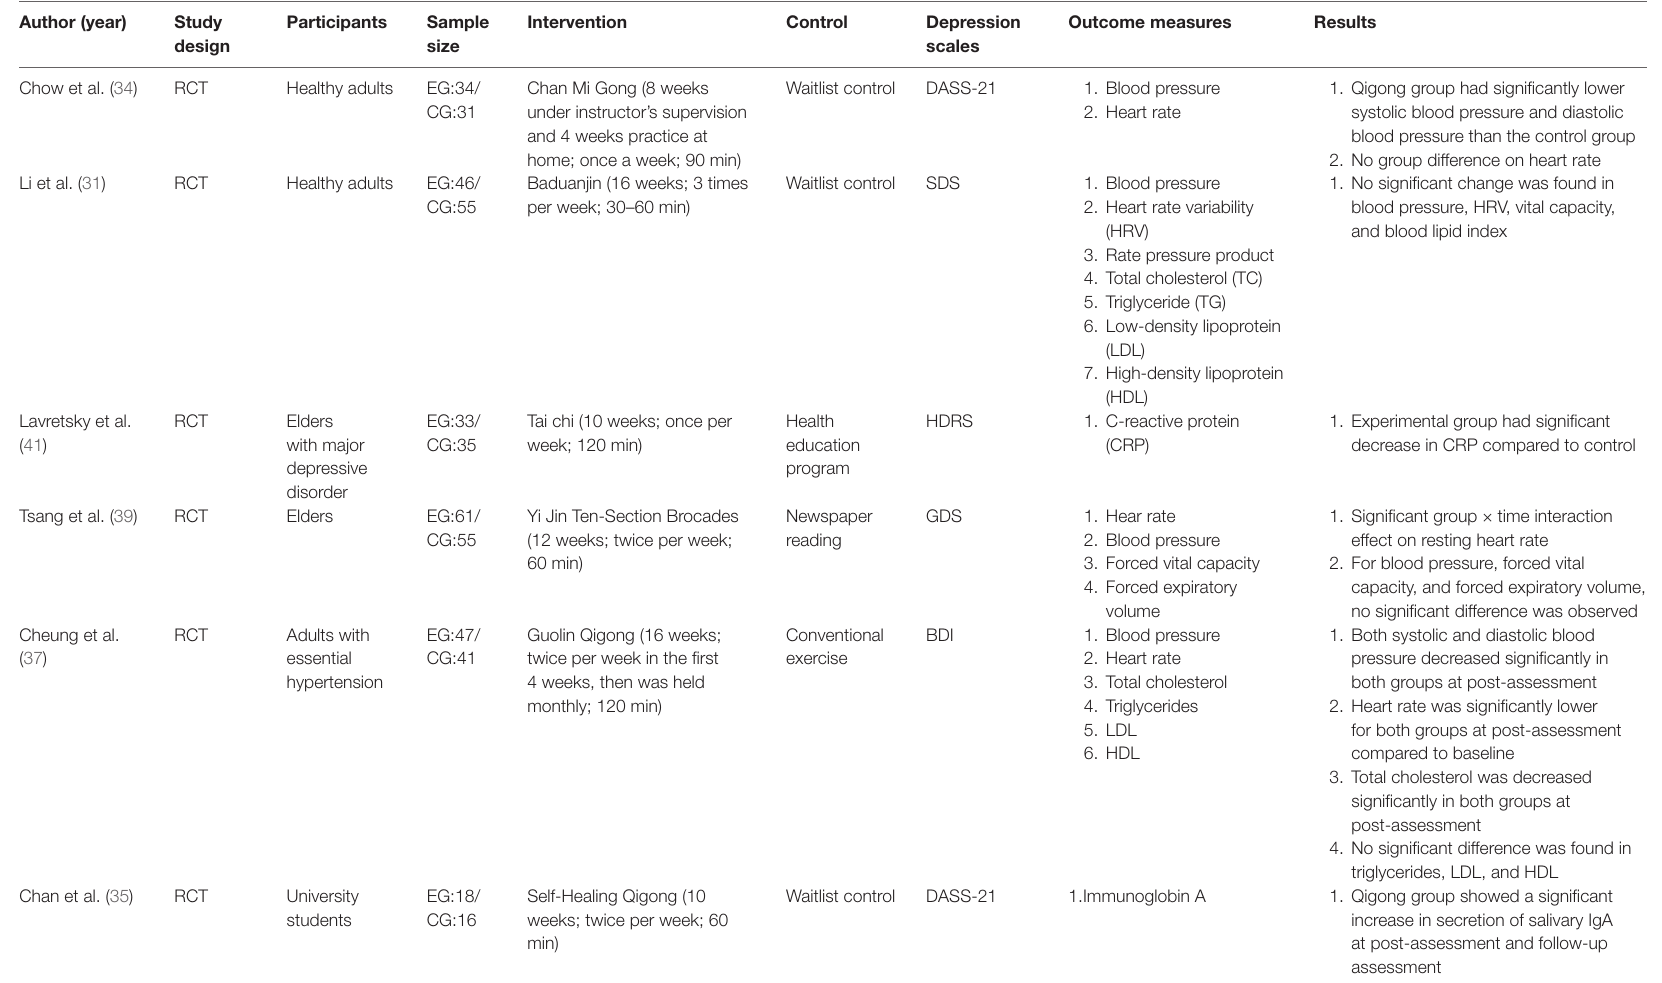
TABLe 2 | Summary of the physiological mechanism of